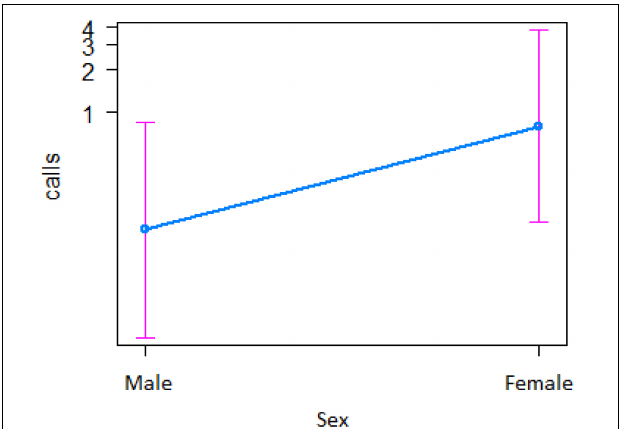
FIGURE 3 | Effect of caller’s sex on the number of calls when finding the snake ( Y -axis in log scale). Sample size 132 adult females, 8 adult males, and 10 juvenile